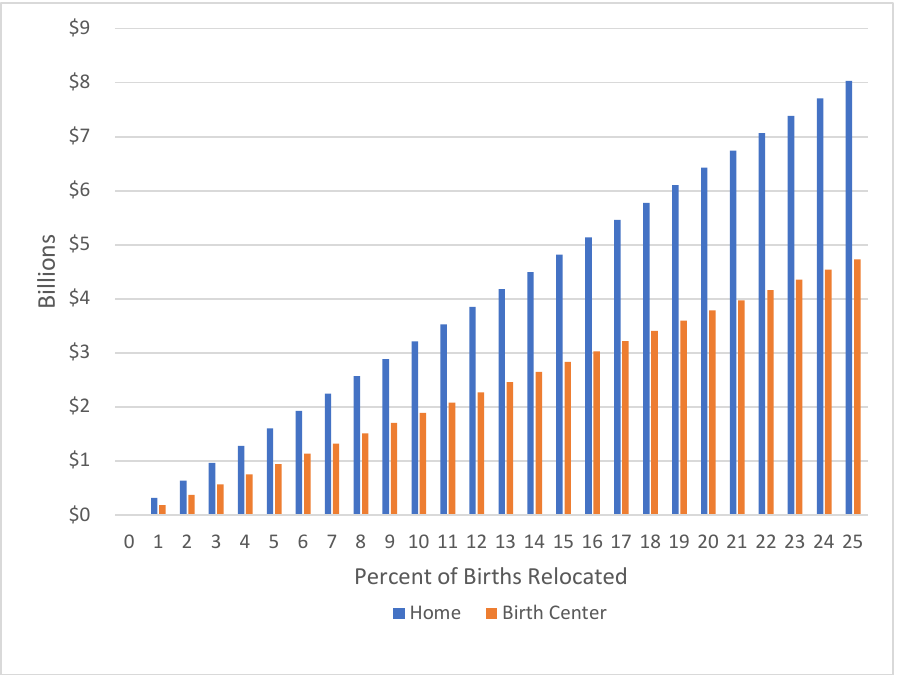
Figure 1. Potential Savings from Increases in the Percent of Out-of-Hospital Births. If greater access and acceptance shift a sizable proportion of births into homes and birth centers, market forces could further alter birth fees and the quality of care. Compe-